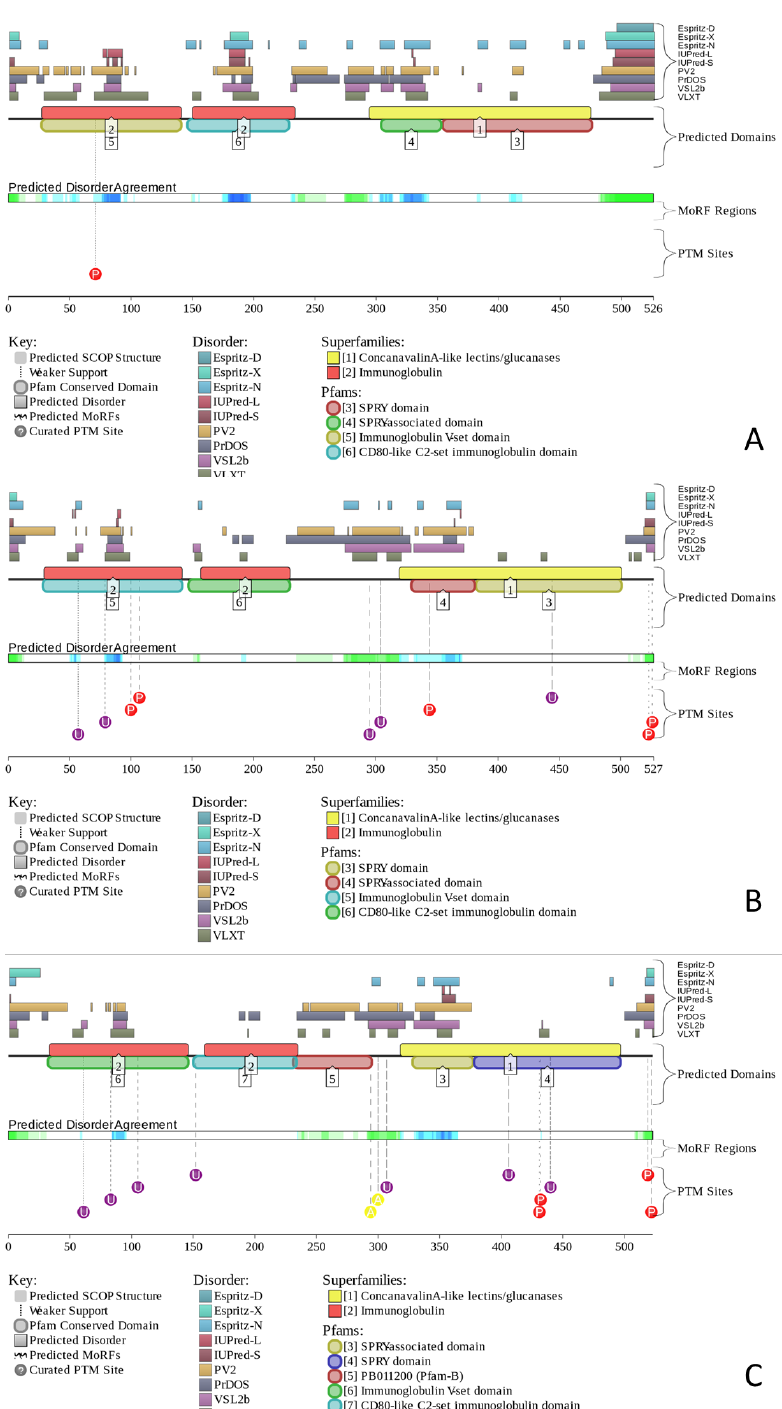
Figure 5. Evaluation of the functional intrinsic disorder propensity of human butyrophilins. Analysis of BT1NA1 ( A ), BT1NA2 ( B ), and BTN1A3 ( C ) was conducted by D 2 P 2 (http://d2p2.pro/) [59]. In each plot, nine colored bars represent location of disordered regions found by different disorder predictors. A set of differently colored bars shows the location of the functional domains found by the Pfam platform, which is a database of protein families that includes their annotations and multiple sequence alignments generated using hidden Markov models [64–66]. Green-blue-and-white bars in the middle of the plots show the predicted disorder agreement between these nine predictors, with green and blue parts corresponding to disordered regions by consensus. Differently colored circles at the bottom of the plots show the locations of various PTMs.